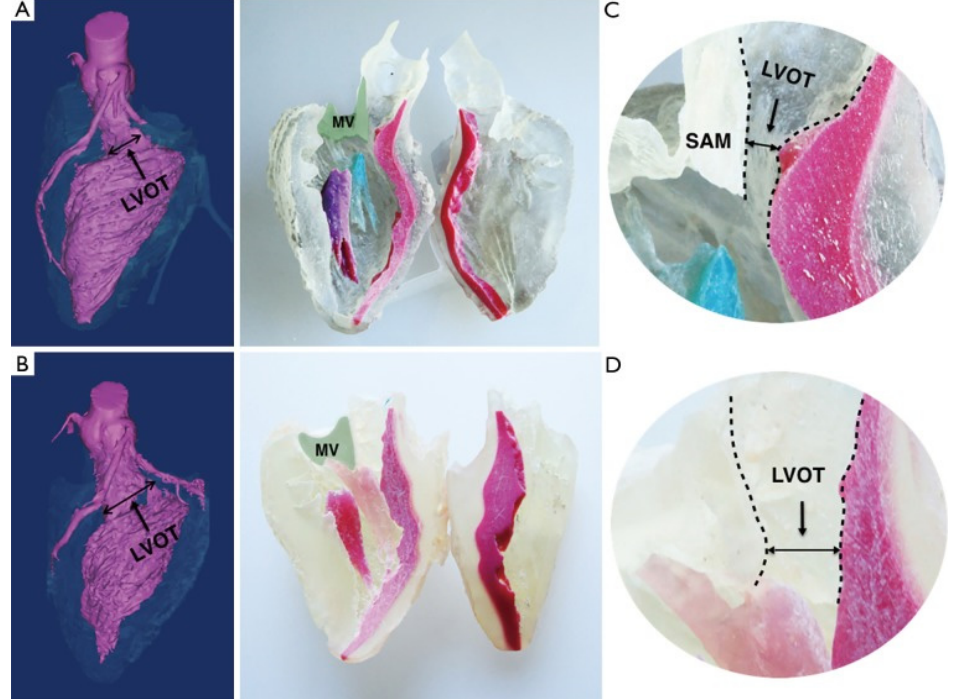
Figure 2. The 3D models of a hypertrophic obstructive cardiomyopathy pre and post-surgical intervention: ( A , B ) show the pre-surgical model; ( C , D ) show the post-surgical model, significantly the enlarged left ventricle outflow tract post-surgery. This image is reprinted under a Creative Commons Attribution 4.0 International License and it is taken from [37].